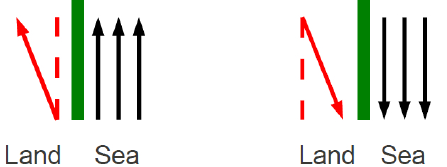
Fig. 2. Plan views of corkscrew (left) and backdoor (right) sea breeze generating scenarios depicting the effect of shore parallel gradient winds on a coastline (green). The black arrows depict the unaltered gradient wind direction. The red arrows portray frictional effects on the gradient flow at the